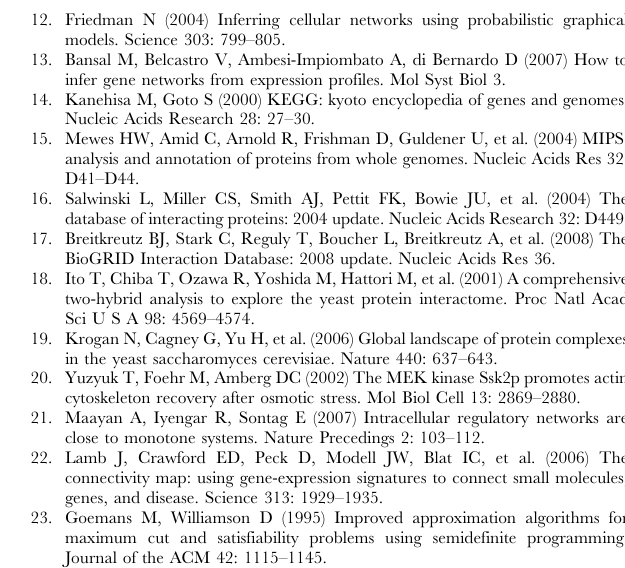
Figure S1 Distribution of the sizes of clusters constructed by the sign-clustering algorithm. Figure S2 The number of predictable knockout pairs as a function of the decision